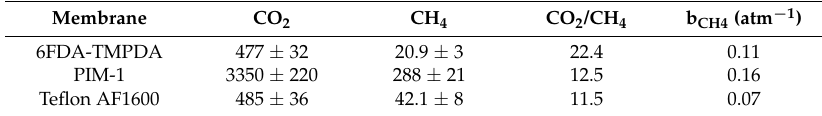
Table 9. Mixed gas permeability (barrer) in pure 6FDA-TMPDA, PIM-1 and Teflon AF1600 membranes, at 35 °C.